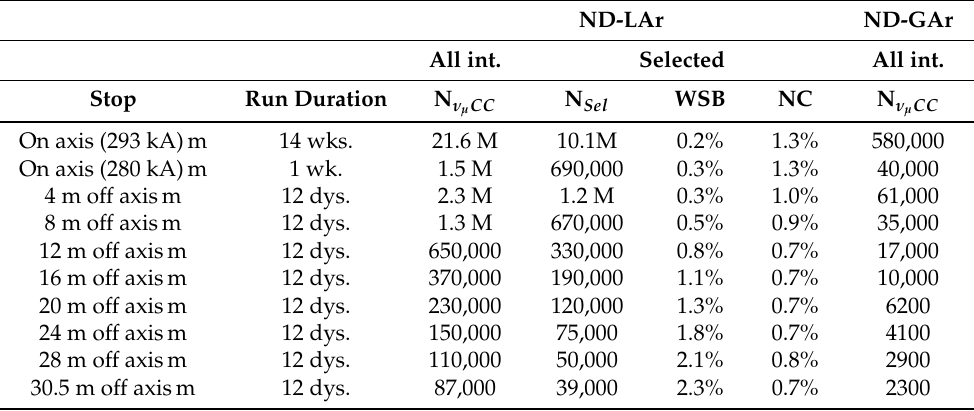
Table 16. A sample run plan is outlined, for which approximately half of the assumed 29 week beam-year the detector is in the on-axis position, one week is spent on axis but with a lower horn current (280 kA), and the remaining time is evenly divided between off-axis positions. The fiducial volume assumed is 4m wide, with the largest off-axis position sampled at 32.5 m, The table shows the rate of ν µ CC events before ( N ν ) and after (N Sel ) the ND event selection, the fraction of wrong-sign µ CC background (WSB), and the fraction of neutral current events (NC). The total number of ν µ CC interactions in the gas is also provided. ND-LAr ND-GAr All int. Selected All int.